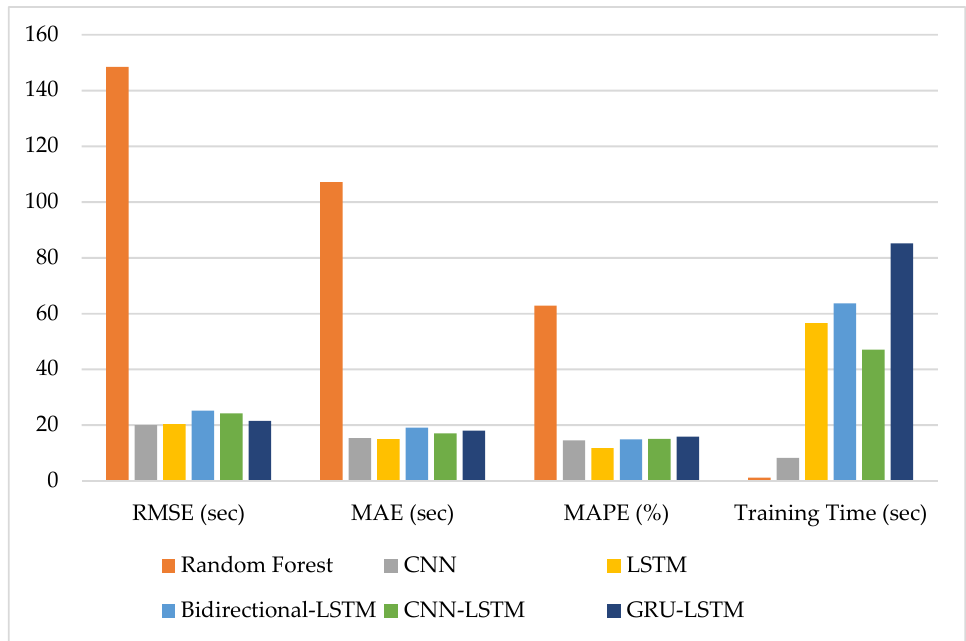
Figure 5. RMSE, MAE, MAPE, and training time for running time prediction .